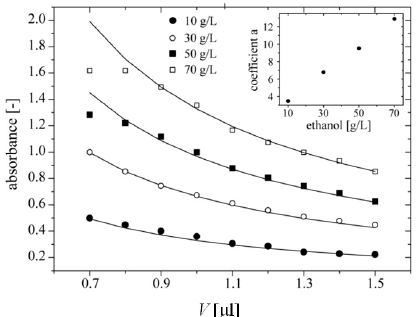
Figure 4. Dependence of absorbance of quinoneimine dye at 490 nm on the volume of a droplet. Each droplet contained 100 nL of sample of ethanol, enzymes (0.75 U·mL −1 of AOX and 12 U·mL −1 of HRP) and chromogenes (0.4 mM of 4-AAP, and 25 mM of PSA). Inset shows linear dependence between coefficient “a” of fitted curves following equation Abs = a ·( V ) −1 and the concentration of ethanol in a 100 nL sample.